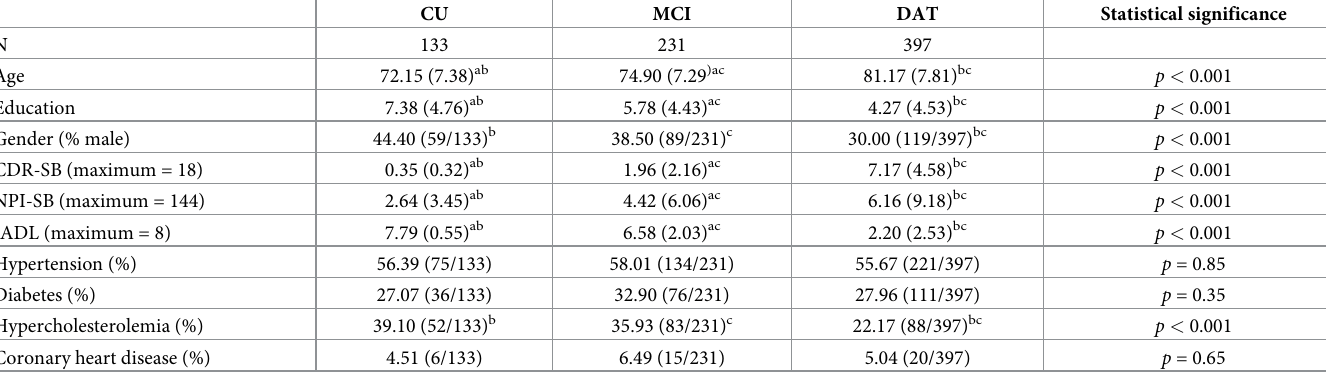
Table 1. Demographic and clinical characteristics across